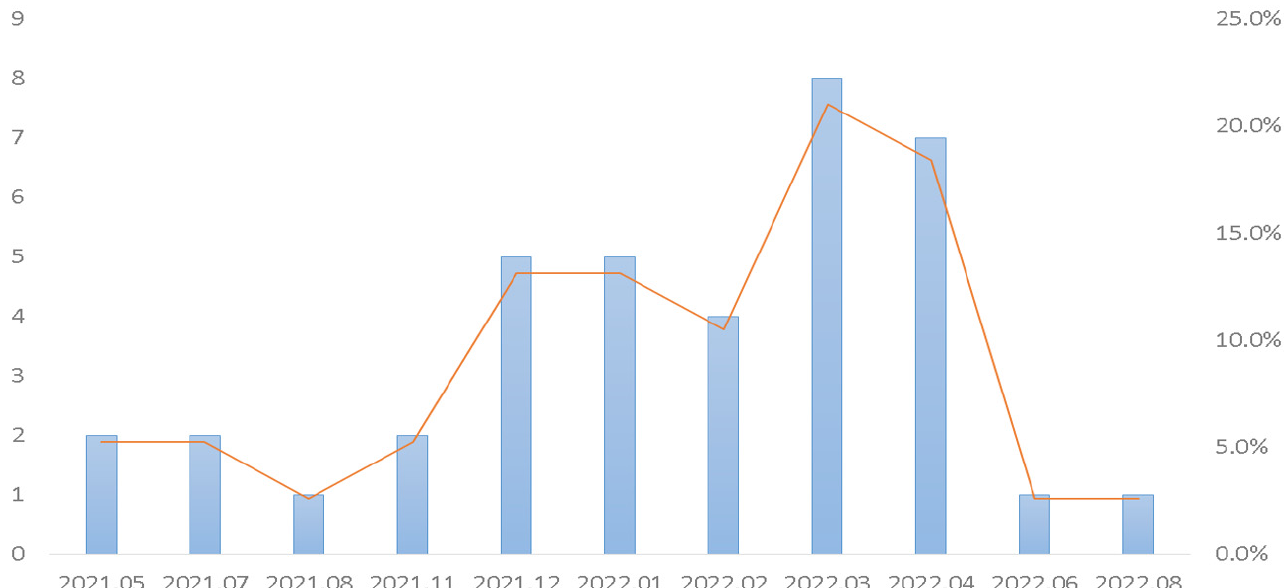
Figure 2. Monthly distribution of isolation rates of rhinovirus/enterovirus from emergency patients in central Taiwan from May 2021 to September 2022.